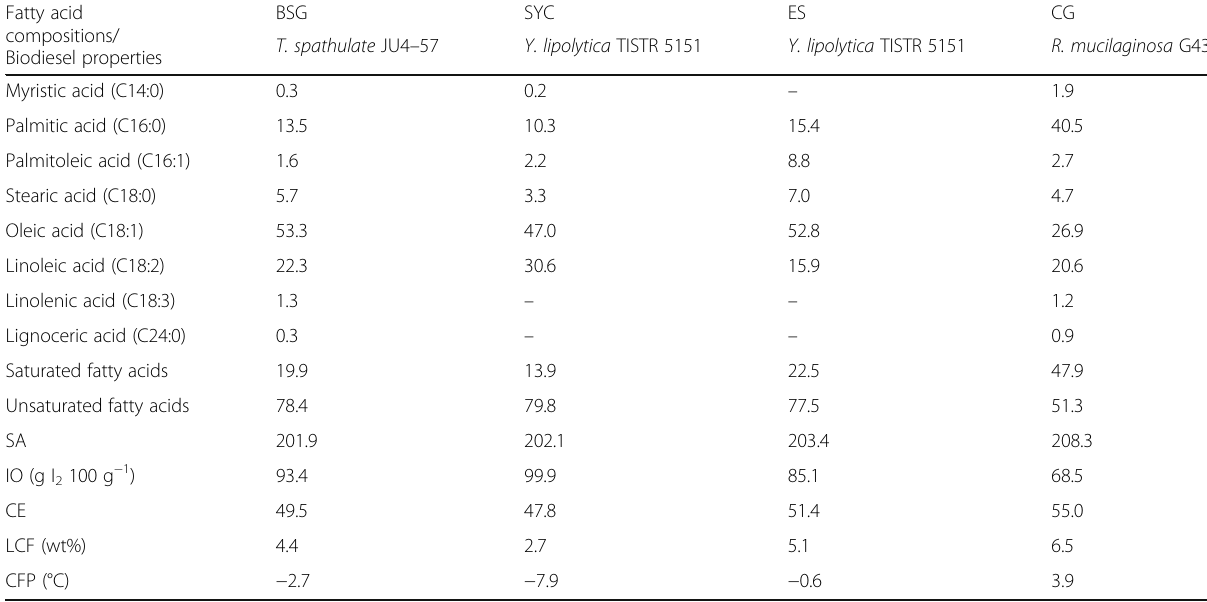
Table 2 Fatty acid compositions (%) and biodiesel properties of yeast